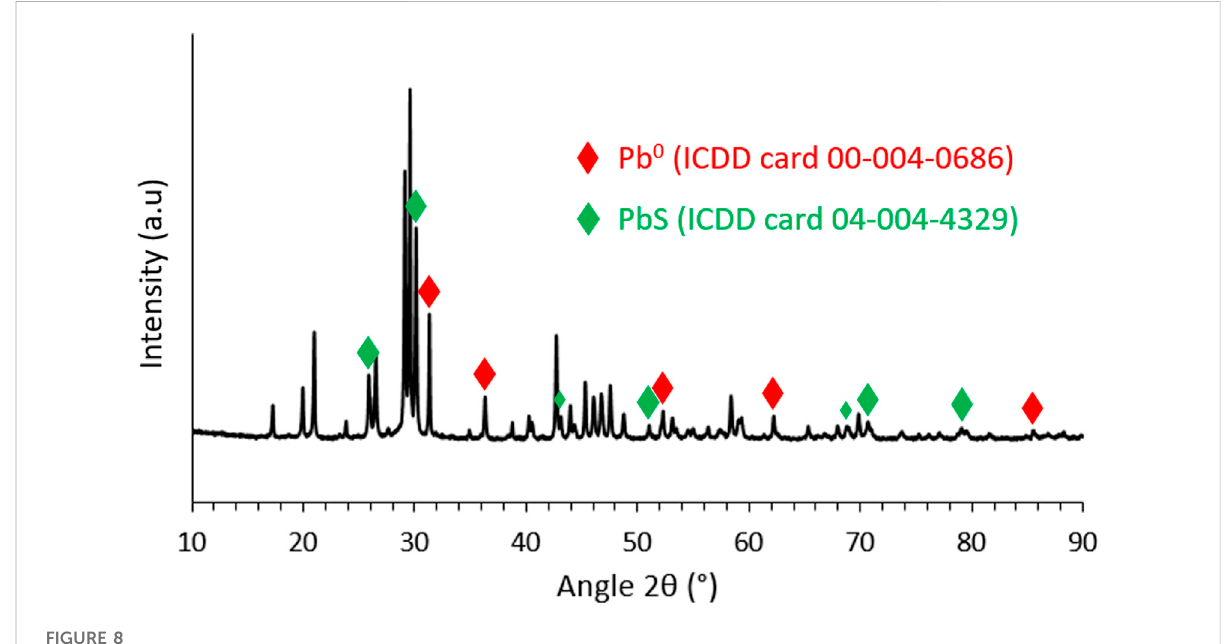
FIGURE 8 X-Ray diffractogram of the